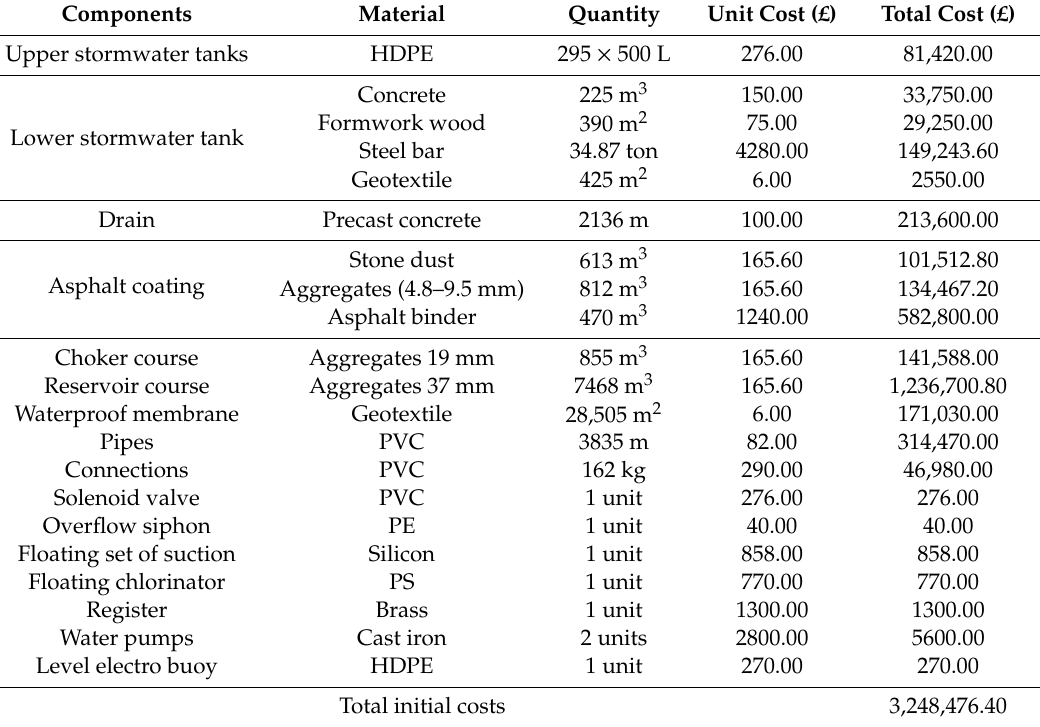
Table 3. Initial costs for the permeable pavement with a stormwater harvesting